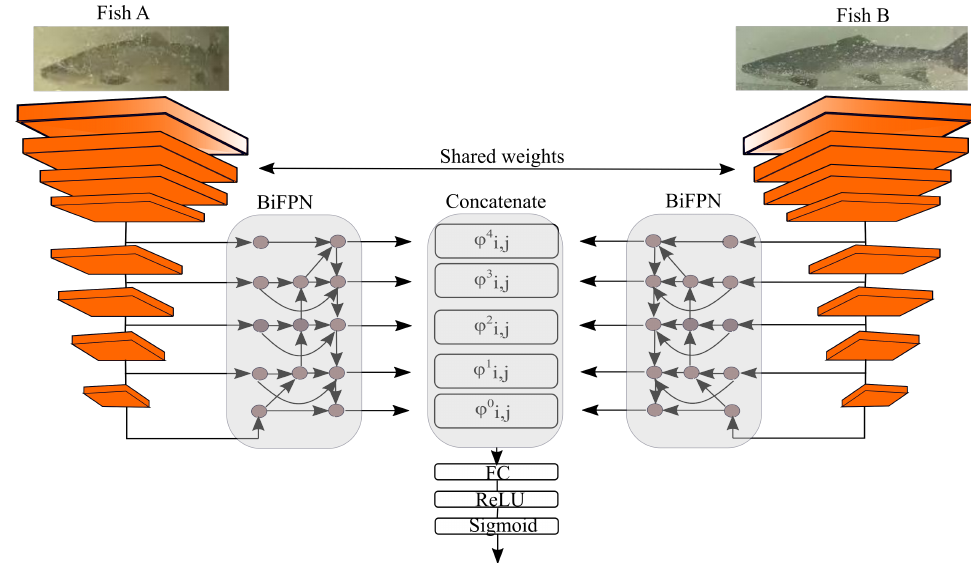
Figure 1. Fish recognition block diagram. Given input images A and B, image features were extracted at different layers of the deep neural network. The similarity between Fish A and B features was computed using the cosine similarity metric φ , which indicated the feature distance between Fish A and B at each scale of the network. FC was a fully connected layer followed by rectified linear activation function (ReLU). The output of ReLU was passed through a Sigmoid function to give a value between 0 and 1, indicating non-identical or identical fishes,